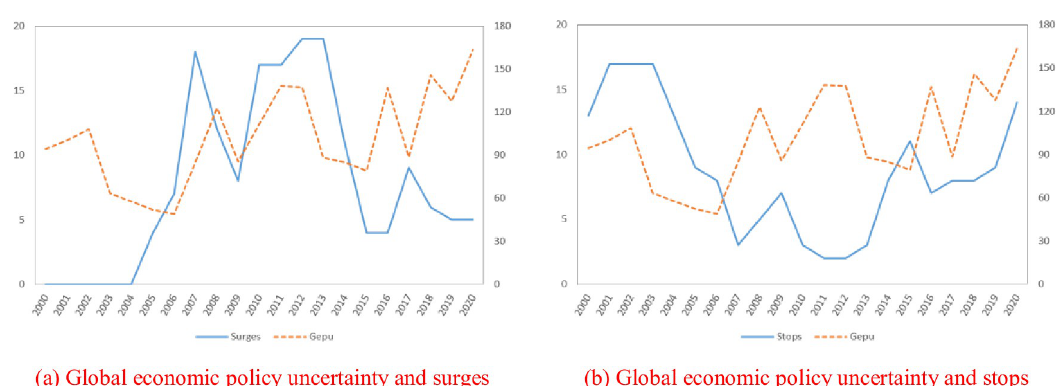
Fig 1. Global economic policy uncertainty and episodes of surges and stops. (a) Global economic policy uncertainty and surges; (b) Global economic policy uncertainty and stops. Notes: Left panel shows the relationship between global economic policy uncertainty and surges, where the blue solid line refers to the number of surges. Right panel shows the relationship between global economic policy uncertainty and stops, where the blue solid line refers to the number of stops. The orange dotted line refers to global economic policy uncertainty index.